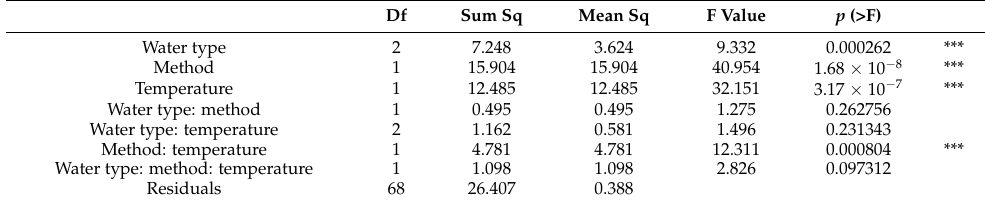
Table 3. Summary of multivariate analysis of